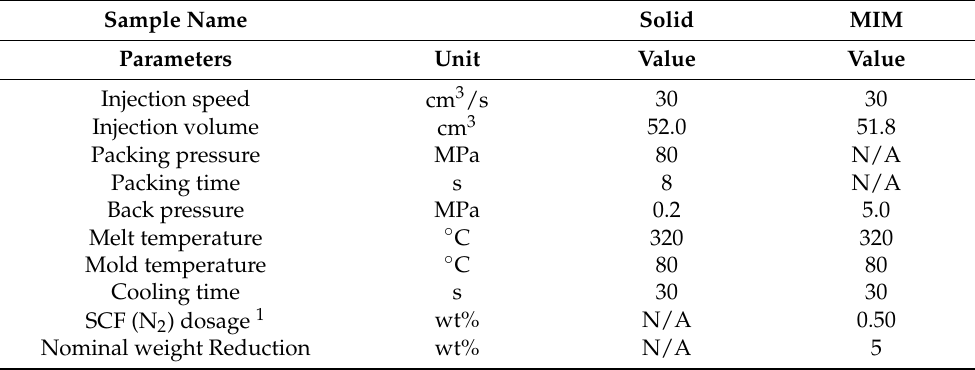
Table 2. Processing parameters for solid CIM and MIM box-shaped parts.